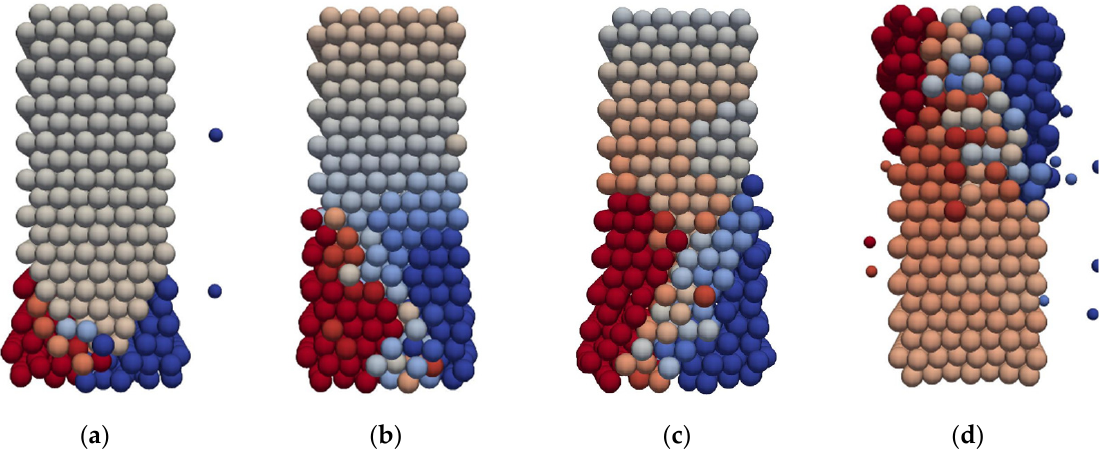
Figure 13. Failure pattern in the uniaxial compressive test for various bond friction coefficients: ( a ) 𝜇 = 0 ; ( b ) 𝜇 = 0.1 ; ( c ) 𝜇 = 0.2 ; ( d ) 𝜇 = 0.3 .